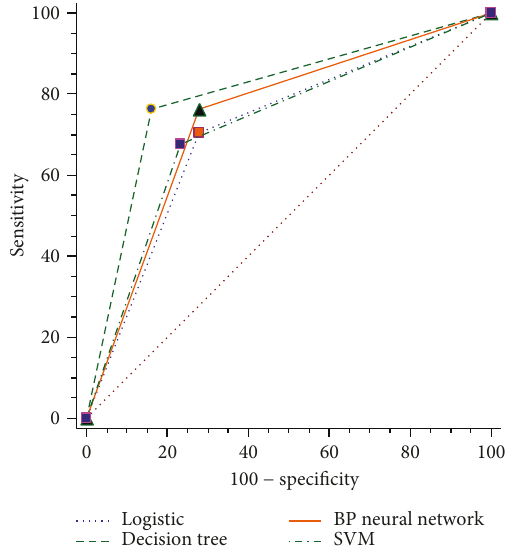
Figure 7: The ROC curve of four prediction